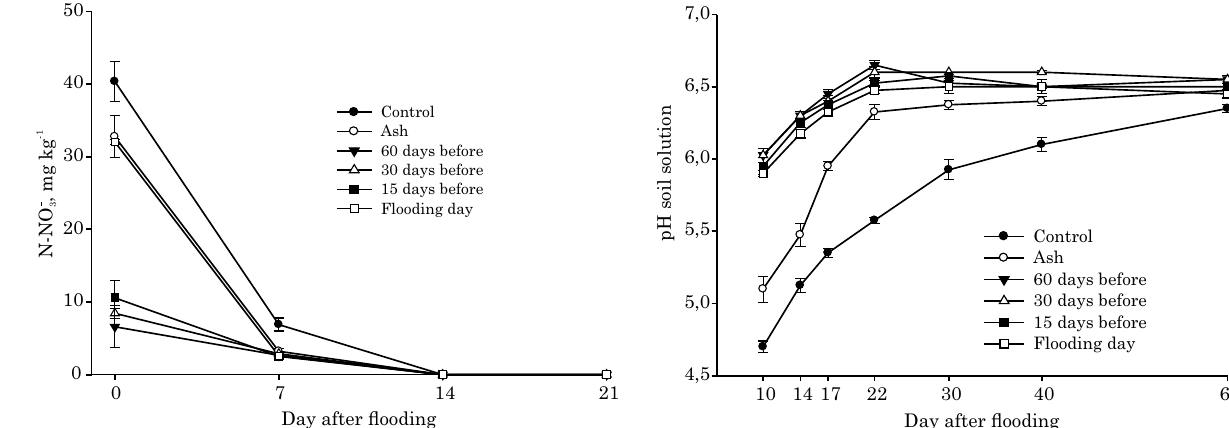
Figure 4. pH of the soil solution after flooding as a function of the time of incorporation of rice straw preceding the soil flooding or incorporation of the ash from burned